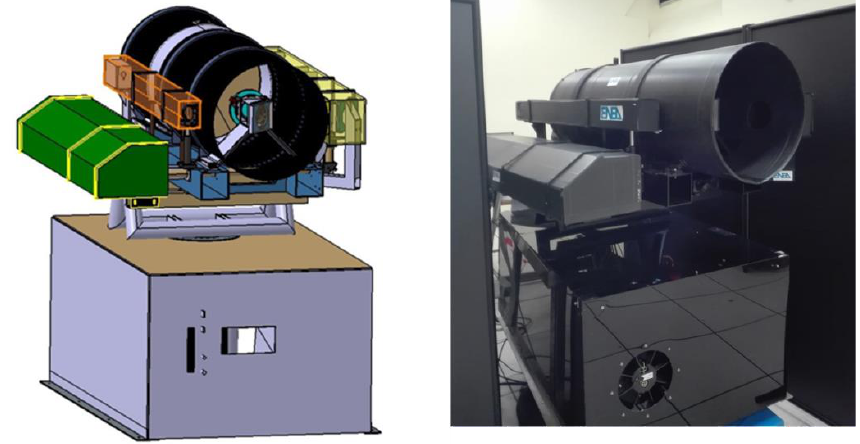
Figure 2. Drawing ( left ) and photo ( right ) of the ILS Prototype 3. Table 1. Specification of the ILS